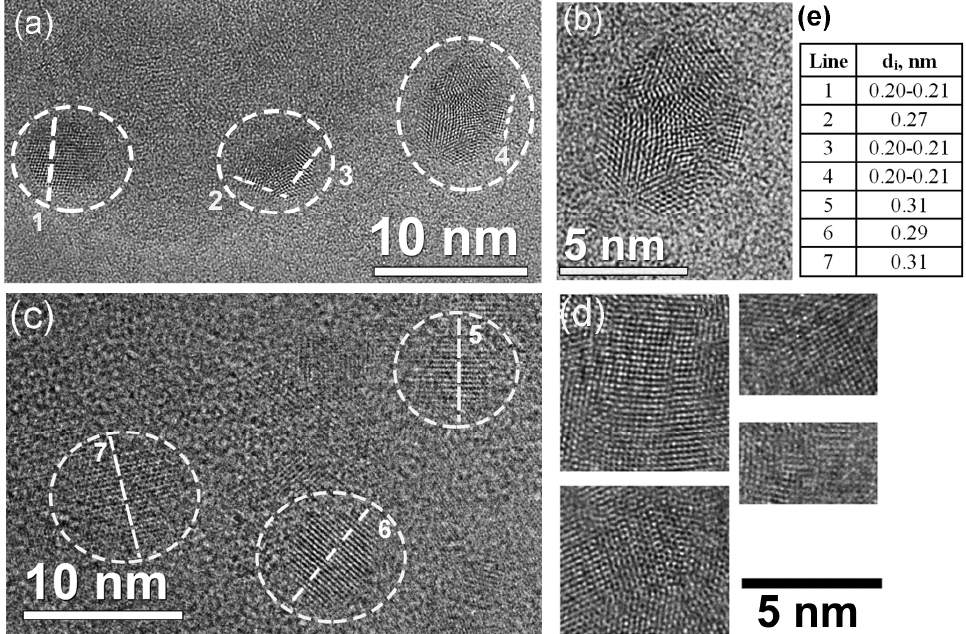
Figure 2. High-resolution transmission electron microscopy (HRTEM) images of nanosized objects embedded in FLG films irradiated with Xe ions. The ion energy was 167 and 26 MeV for ( a ) and ( c ), respectively. The irradiation dose was the same for ( a ) and ( c ), which was 5 × 10 11 ion/cm 2 . The enlarged image of the top left part of ( a ) is shown in ( b ). Enlarged fragments of the TEM images for the FLG films, irradiated with 26 MeV Xe ions at the dose 1 × 10 11 ion/cm 2 , are shown in ( d ). Information about the interlayer distance values for lines 1–7 is shown in the table in ( e ).